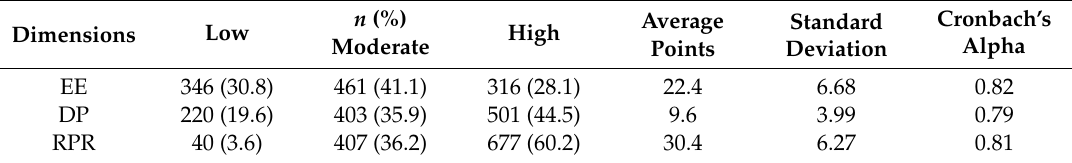
Table 1. Frequency distribution of the Emotional Exhaustion (EE), Depersonalization (DP) and Reduced Professional Achievement (RPR) dimensions among Primary Health Care nursing professionals in Bahia, Brazil in 2018 ( n = 1121).